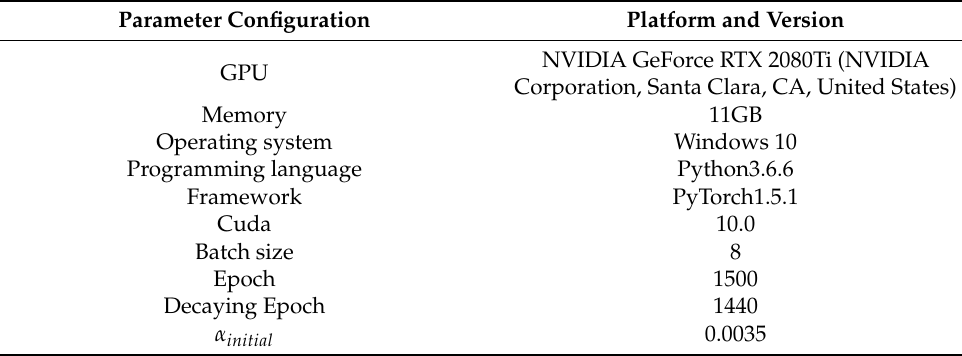
Table 1. Training platform and parameter configuration